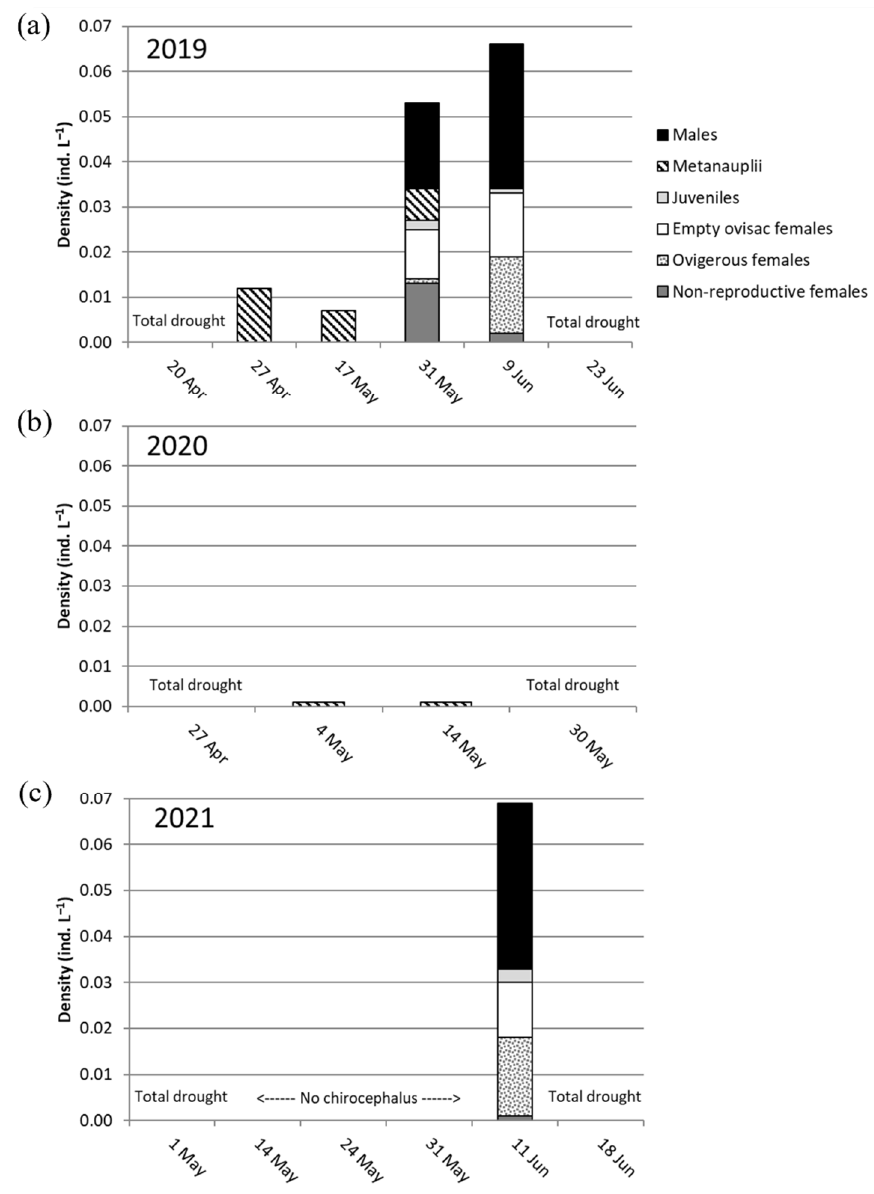
Figure 7. Mean densities (individuals [ind.] L ‒ 1 ) of each Chirocephalus sibyllae life stage in the